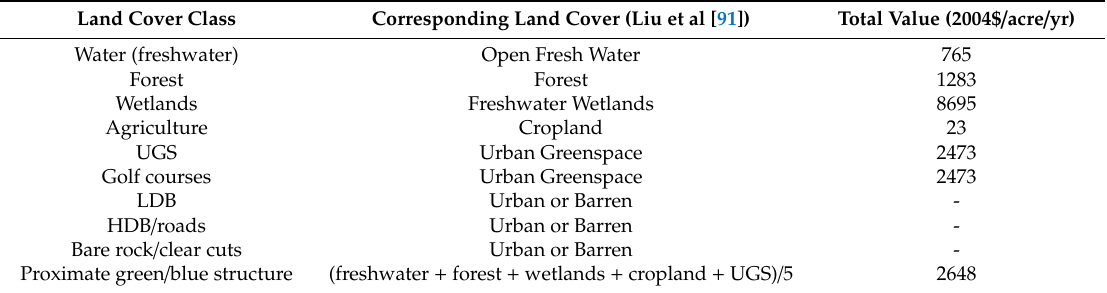
Table 3. Land cover classes and corresponding ecosystem service values in USD (2004 exchange rate) per acre and year adapted from Liu et al.